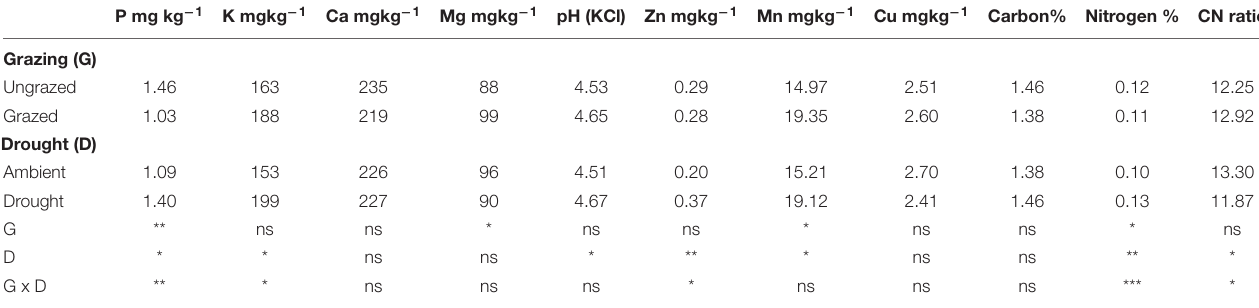
TABLE 2 | Effect of grazing and drought on selected chemical properties of the soil (0–30 cm).